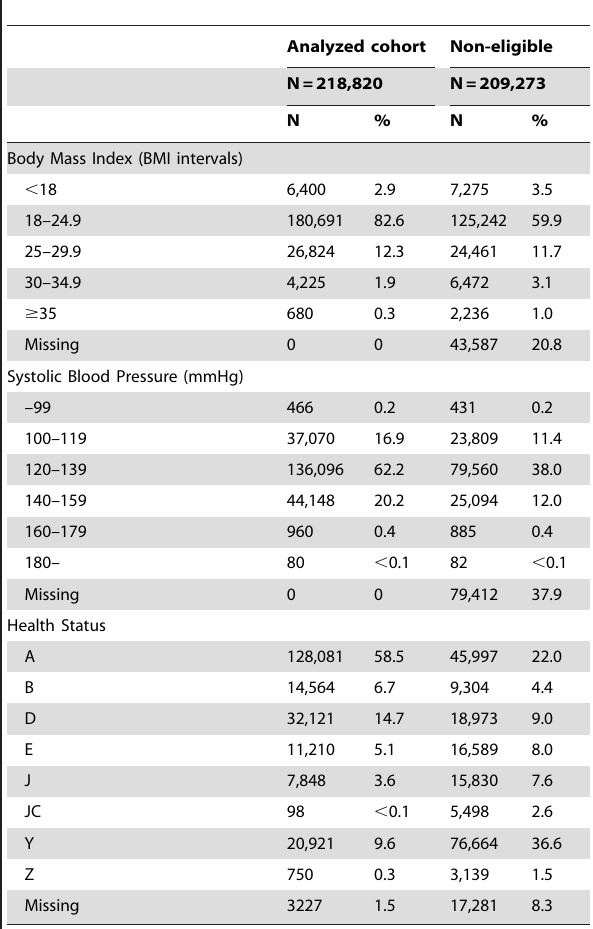
Table 3. Characteristics at conscription - analyzed cohort vs. non-eligible subjects.